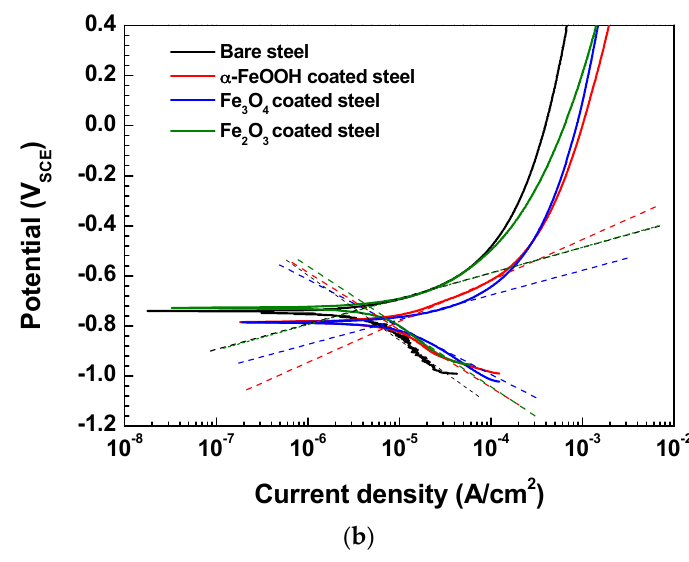
Figure 3. ( a ) Polarization curves in the form of I = f ( E ) and ( b ) polarization curves with Tafel slopes of the specimens covered with different iron oxides ( α -FeOOH, Fe 3 O 4 , Fe 2 O 3 ) and uncovered after 6 h of immersion in the simulated district heating water at 40 °C.